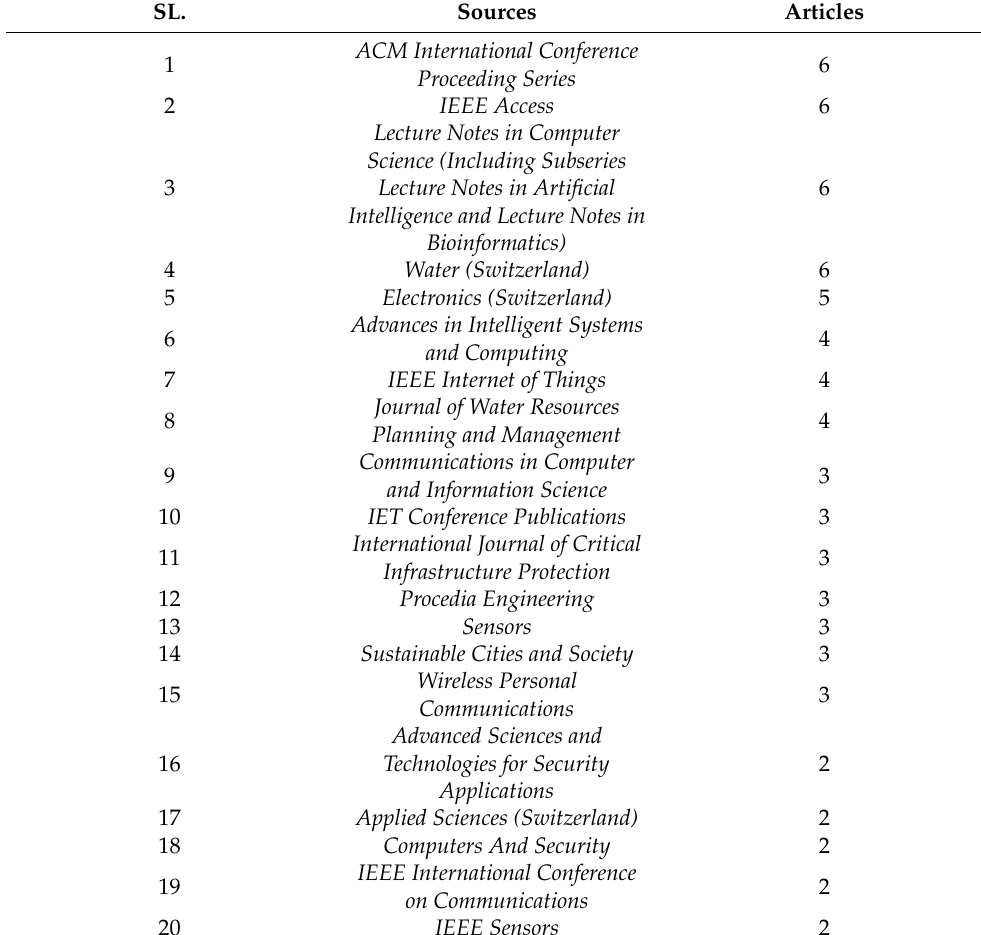
Table 5. The most relevant sources of research.